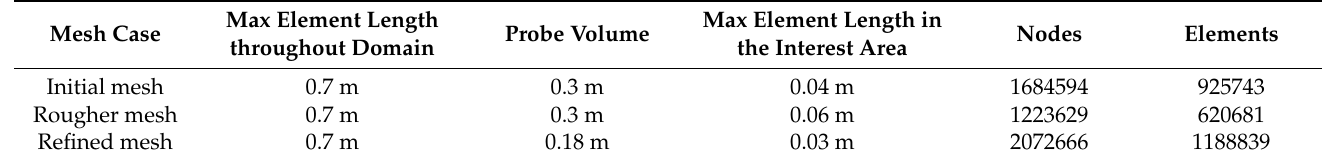
Table 2. Mesh metrics for the initial mesh, the rougher mesh, and the refined mesh.